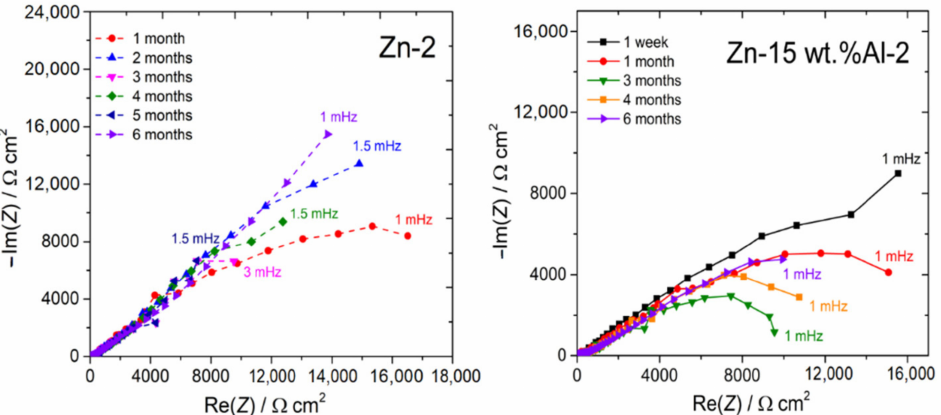
Figure 7. EIS study of the coated electrodes: evolution of the Nyquist plots for Zn-2 and Zn-15wt.% Al-2 during the 6-month galvanic corrosion experiment. EIS measurements were performed with the electrode at OCP, i.e., disconnected from its paired bare steel